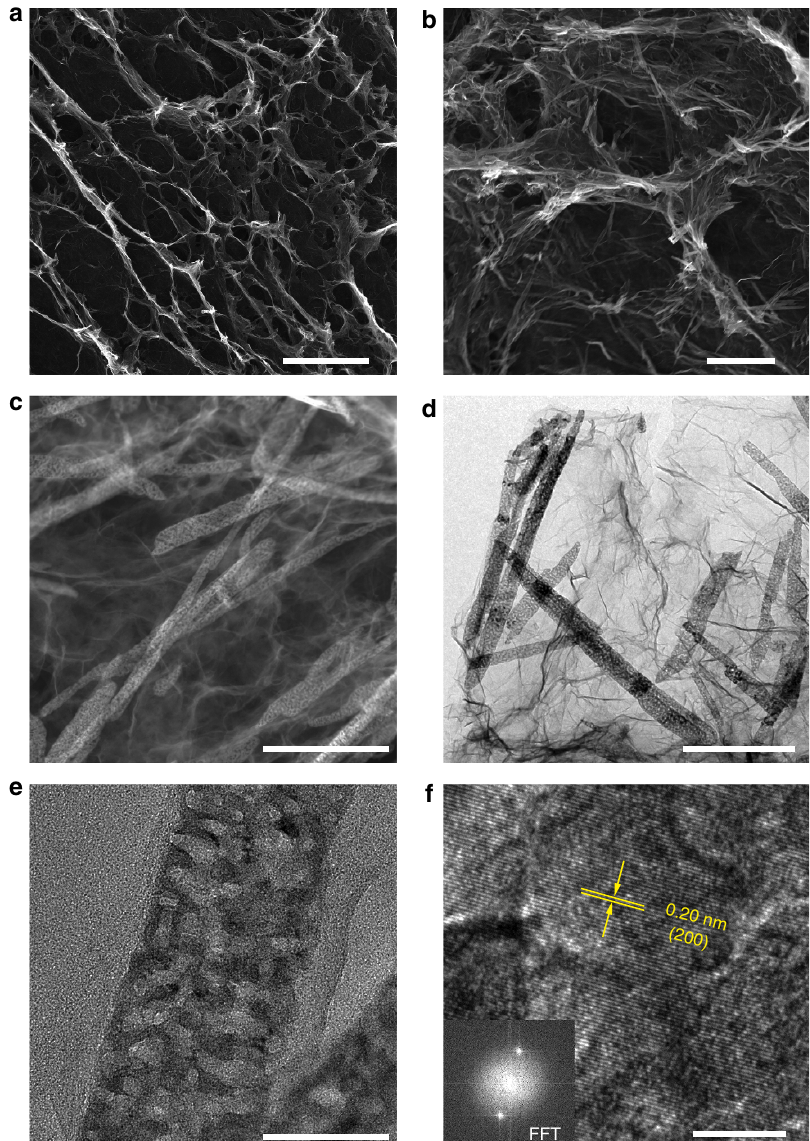
Figure 2 | Morphology and structural characterization of the VN/G composite. ( a ) Low-magnification SEM image, ( b ) high-magnification SEM image, ( c ) high-angle annular dark-field (HAADF) STEM image and ( d , e ) TEM images of the as-prepared porous VN/G composite. ( f ) High-resolution TEM (HRTEM) image, with inset showing the fast Fourier transform (FFT) pattern. Scale bars, ( a ) 100 m m; ( b ) 2 m m; ( c ) 500nm; ( d ) 500nm; ( e ) 50nm; ( f )